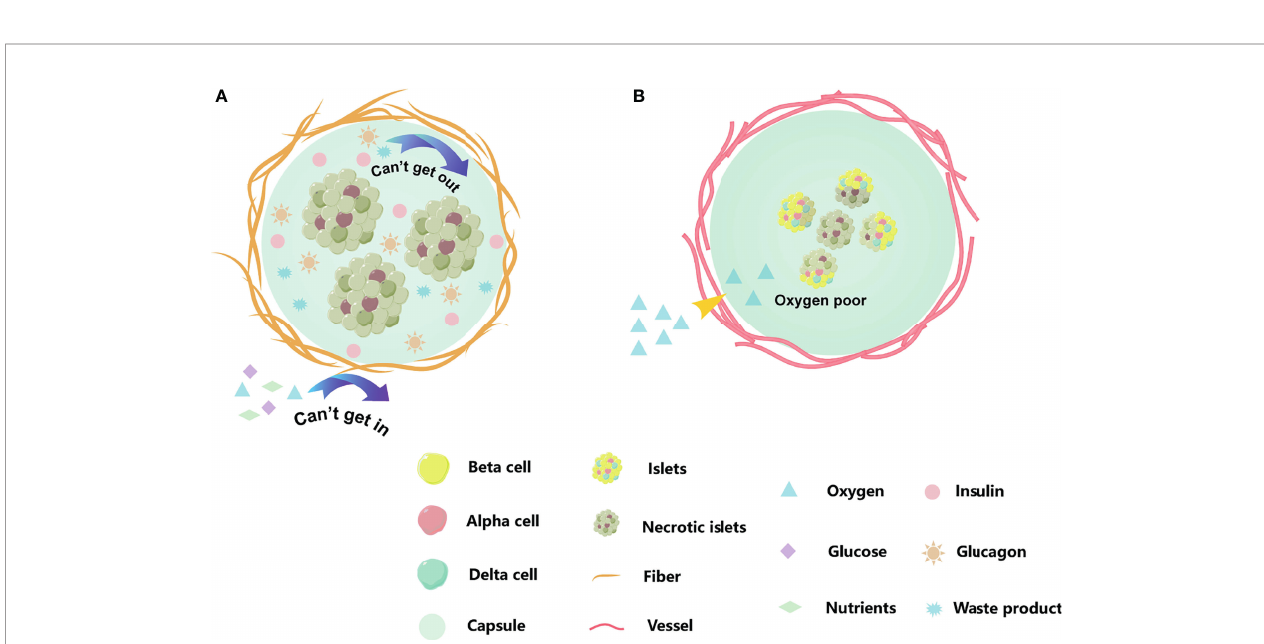
FIGURE 3 | Existed problems for islets encapsulation. (A) A dense peri-capsular fi brotic overgrowth, FBR usually limits the diffusion of nutrients and oxygen to the implant, or prevents insulin release and waste discharge. (B) The encapsulation we moved into recipient acted as a physical barrier, blocking blood vessels from growing into the capsule. The cell of capsule center by hypoxia. The orange strips are fi ber, and the red cords are blood vessel. When islet cells are affected by hypoxia or cellular metabolites, they change from bright yellow to dark